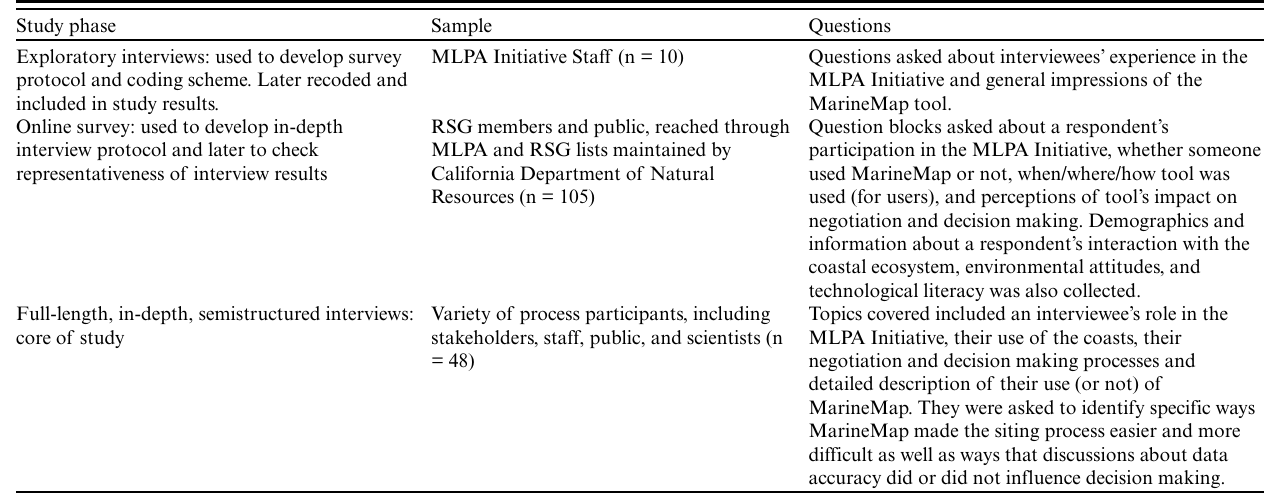
Table 2 . Iterative study design. Acronyms: Marine Life Protection Act (MLPA); Regional Stakeholder Group (RSG). For more about the study design, including interview questions, see the expanded version of Table 2 in Environmental Management 57(2), AE Cravens, “Negotiation and decision making with collaborative software,” pp 474-497, copyright 2016. Reprinted with permission of